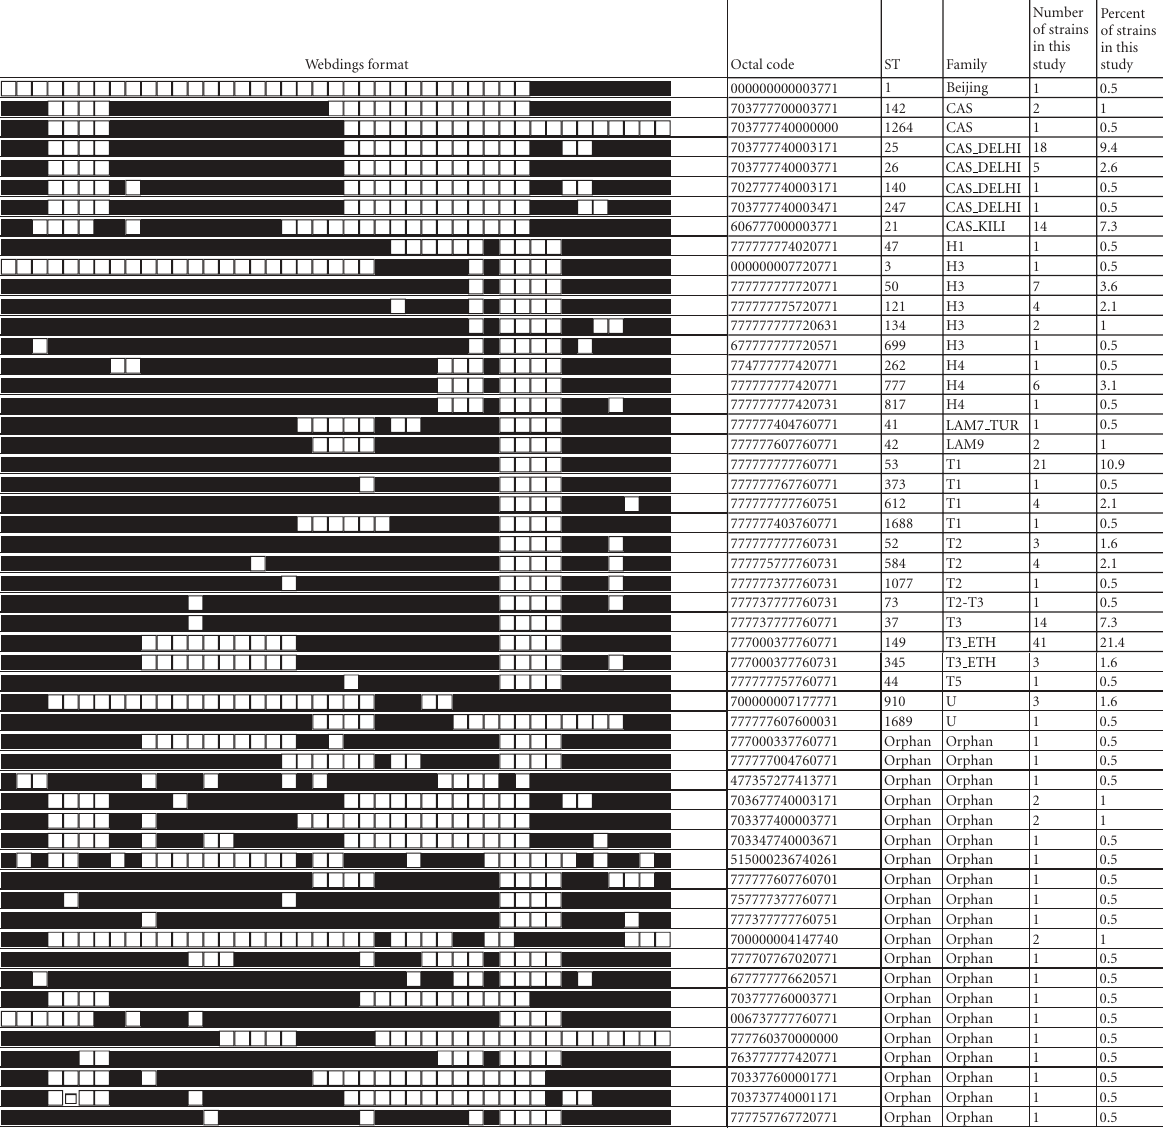
Figure 1: Spoligotype pattern of clustered M. tuberculosis strains. The black and white boxes indicate the presence and absence, respectively, of the specific spacer at position 1 to 43 in the DR locus. CAS = Central Asian; LAM = Latin American-Mediterranean; H = Haaralam, and U =